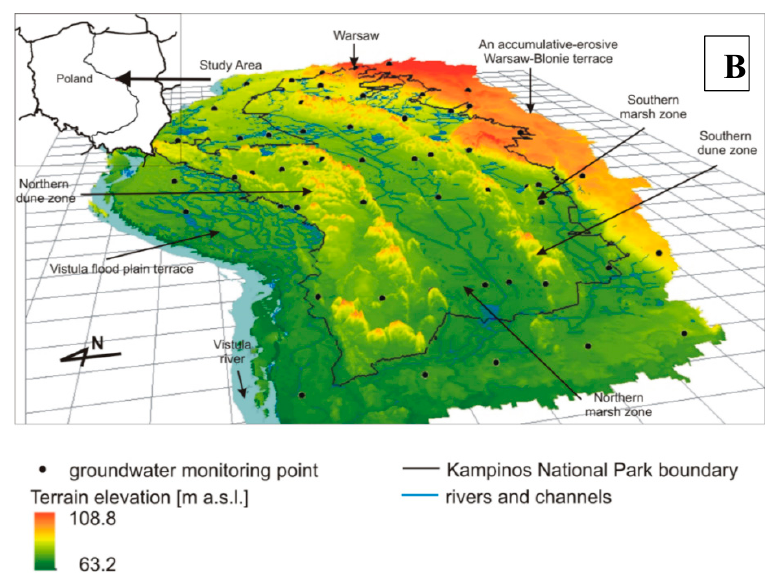
Figure 1. Location of the study area: ( A )—on the background of Major Groundwater Reservoir no. 222; ( B )—groundwater monitoring points (adapted from [35,36]).